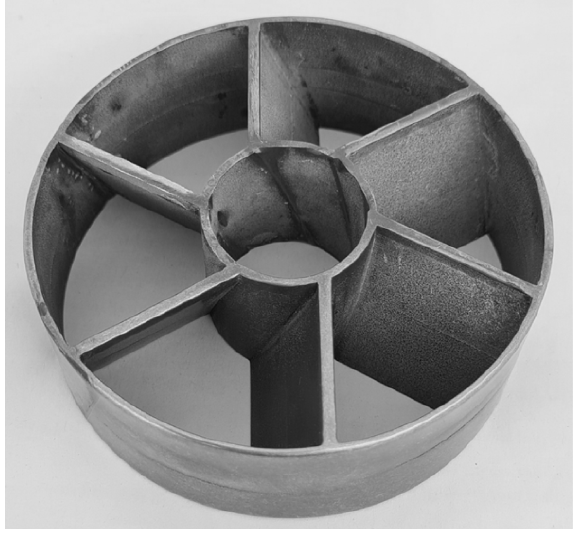
Figure 14. SLMed propeller for case study 2.